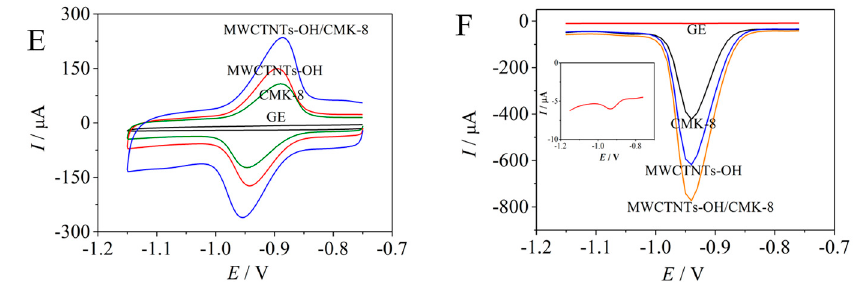
Figure 2. CVs ( A ) and DPVs ( B ) of 1.0 μ mol/L OLA and CBX on modified electrode. CVs ( C ) and DPVs ( D ) of 1.0 μ mol/L OLA on modified electrode. CVs ( E ) and DPVs ( F ) of 1.0 μ mol/L CBX on modified electrode. The inserted graph is the enlarged DPV curve of the GE. The scanned buffer was 0.6 mol/L of Na 3 PO 4 .